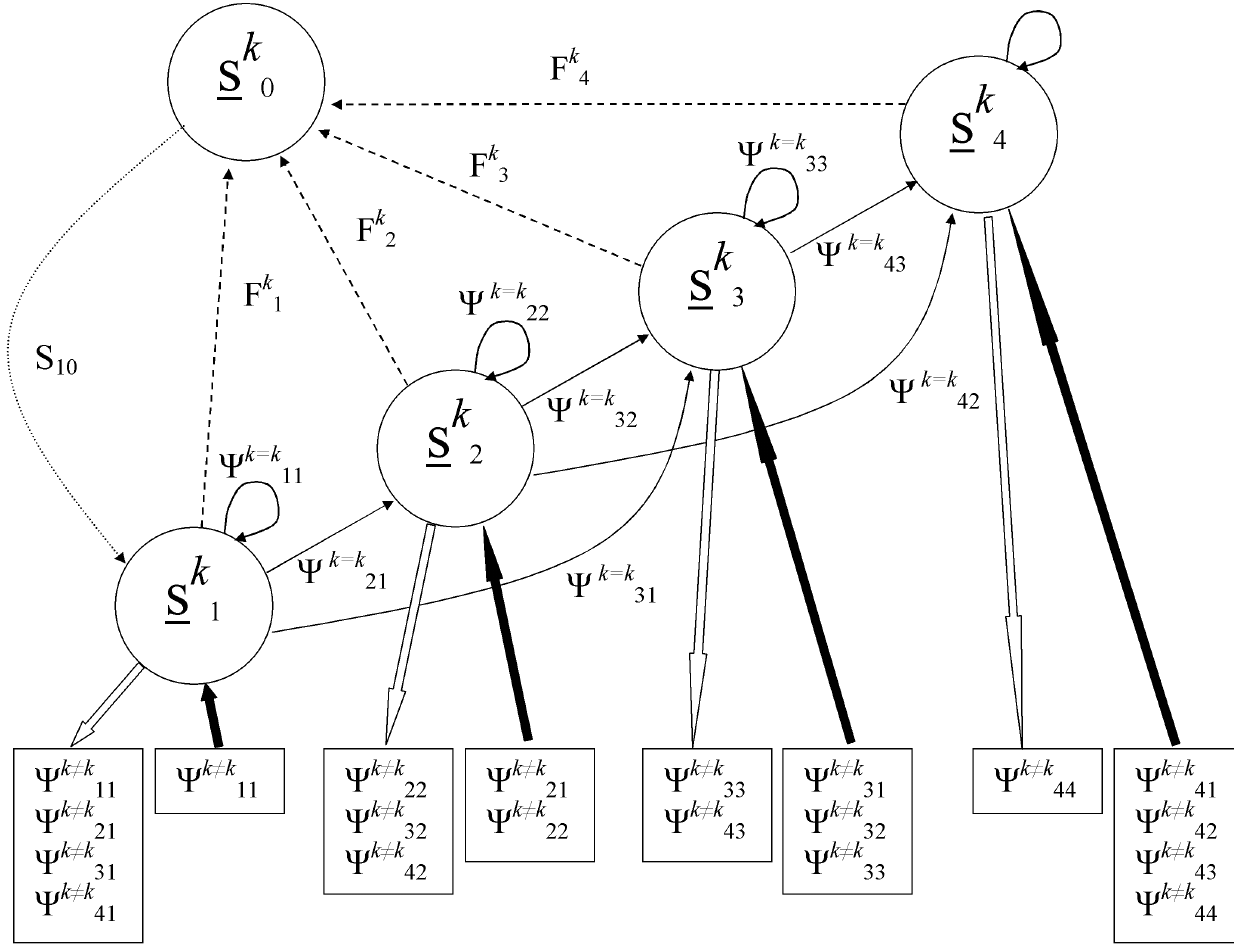
Figure 6. Graphical representation of the life history and spatial transition model. For simplicity, the full life history model with each size state (s) is shown for a single location ( k ) only. Transitions from size states j to i are represented by Y k=k ij within a location and fecundities for each size state are represented by F k s . The only parameter not estimated from field data was survival from size state 0 to size state 1 (S 10 ). Transitions between locations Y k ? k ij are listed in boxes for individuals leaving (open arrows) or entering river k (closed arrows).